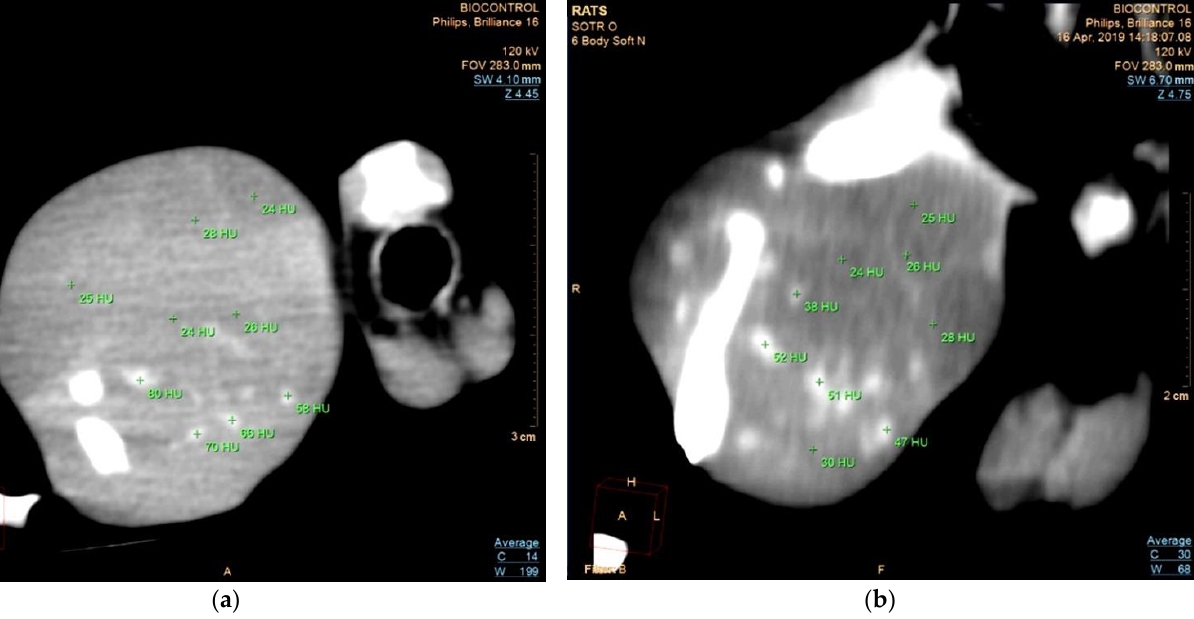
Figure 5. The cross-sectional images of the tumor nodule in the rat femoral muscle from two different angles after 14 days of the intraarterial administration of “NH1”: ( a ) transverse and ( b ) sagittal planes. Additional cross-sectional images of the tumor nodule are presented in Supplementary Materials Section S5.